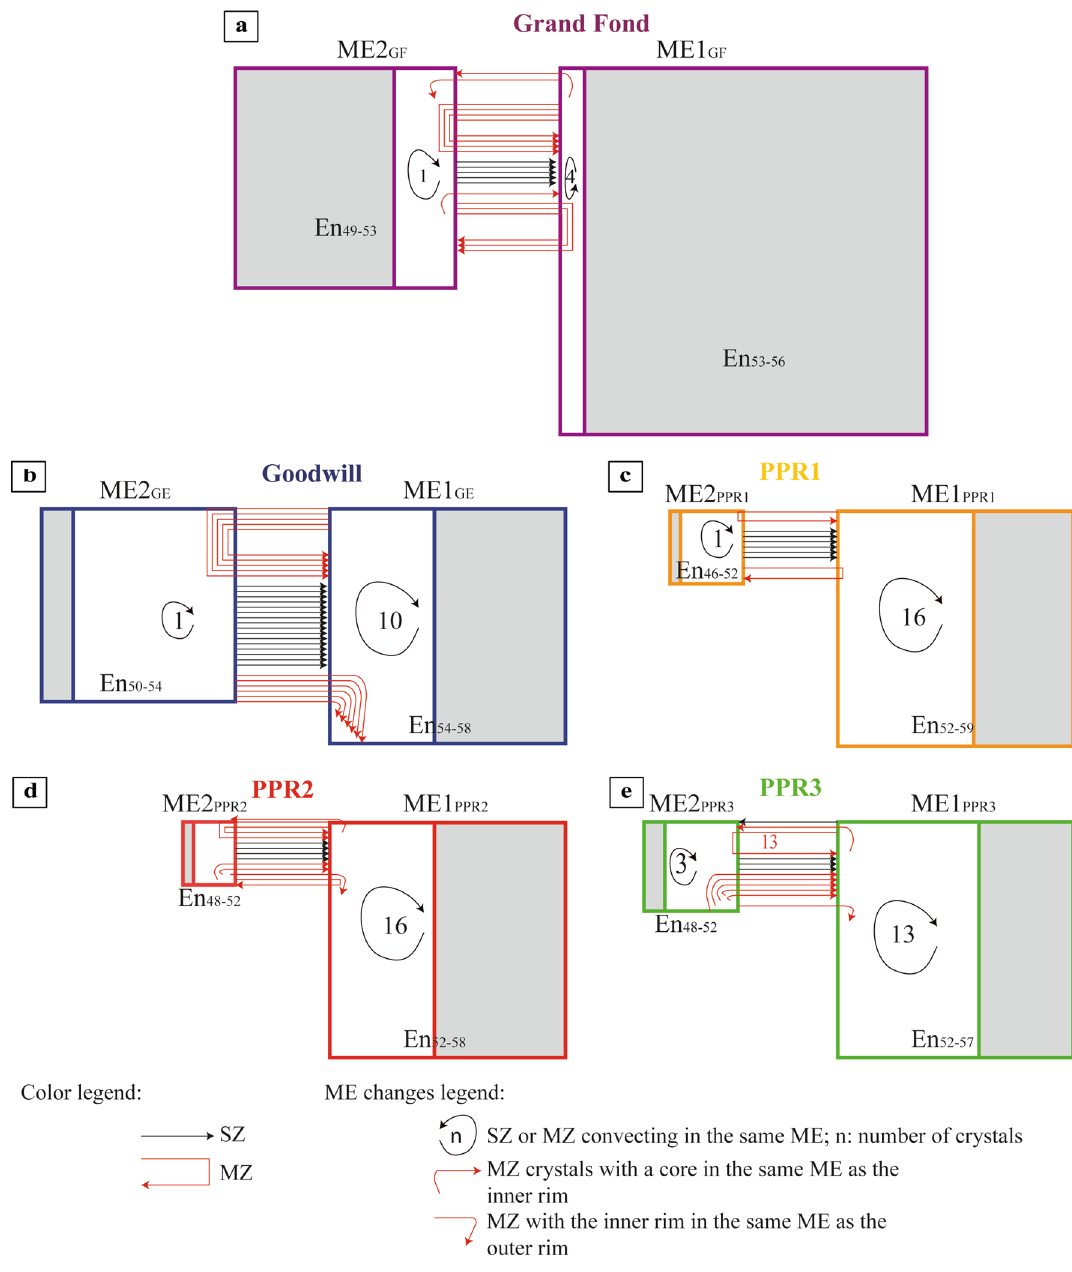
Figure 6. Crystal System Analysis approach of the zonations recorded by the two populations of opx of the five eruptions studied [Grand Fond ( a ), Goodwill ( b ), PPR1 ( c ), PPR2 ( d ) and PPR3 ( e )]. Each box represents a magmatic environment (ME): ME1 GF = En 53-56, ME2 GF = En 49-53 ; ME1 GE = En 54-58, ME2 GE = En 50-54; ME1 PPR1 = En 52-59, ME2 PPR1 = En 46-52 ; ME1 PPR2 = En 52-58, ME2 PPR2 = En 48-52 ; ME1 PPR3 = En 52-57, ME2 PPR3 = En 48-52, for Grand Fond, Goodwill, PPR1, 2 and 3, respectively. For each eruption, the size of the boxes is approximately proportional to the proportions of unzoned and cores of zoned opx in each ME, using the volumes of ME calculated in Supplementary Table S4. The grey zones show the proportions of unzoned crystals and the white areas, the proportions of zoned crystals (reset to 100%, Supplementary Table S4). The change of ME recorded from the core to the rim of opx is represented with a black arrow for single-zoned (SZ) crystals and a red arrow for multiple-zoned (MZ) crystals. For PPR3 ( e ), 13 multiple-zoned crystals record a change from ME1 PPR3 to ME2 PPR3 (13 in red). In the case of the studied magmas, an En increase (reverse-zoned) implies a temperature increase, with, or without, magma mixing with a more basic and hotter magma. Conversely, an En decrease (normal-zoned) may be linked to a pressure drop, decrease in melt H 2 O content or mixing with a colder magma 38 . This Figure has been drawn using Adobe Illustrator (Version 24.0.1; https:// www. adobe. com/ fr/ produ cts/ illus trator.